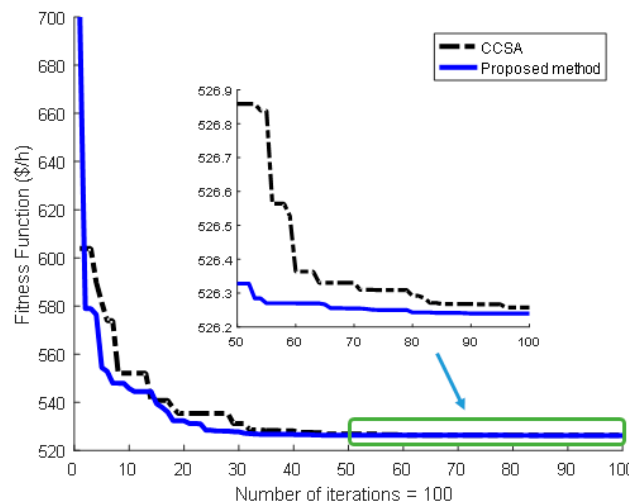
Figure 4. Fitness function curves iteration obtained by the conventional cuckoo search algorithm (CCSA) and proposed method for sub-case 1.2.